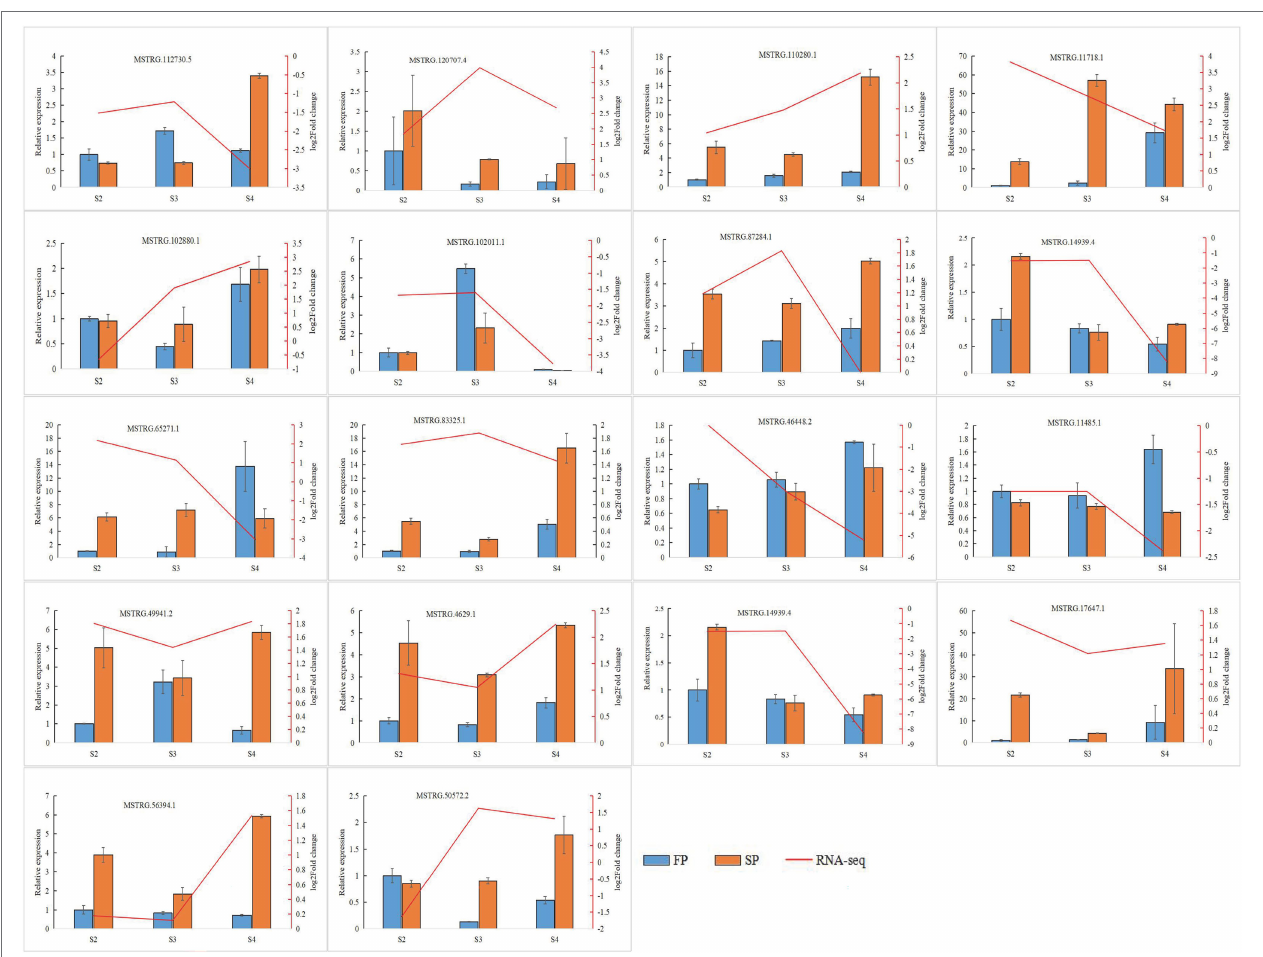
FIGURE 8 | Quantitative real-time PCR validation of six identified key miRNA-mRNA interaction pairs for patchouli in response to continuous cropping. Six identified key miRNA-mRNA interaction pairs are osa-miR159f-MSTRG.97625.2, novel17_mature-MSTRG.83027.3, gma-miR172k-MSTRG.90185.1, novel17_star- MSTRG.45166.2, aly-miR172e-3p-MSTRG.38549.4, and ama-miR156-MSTRG.111696.3. The error bar represents the error values of three biological